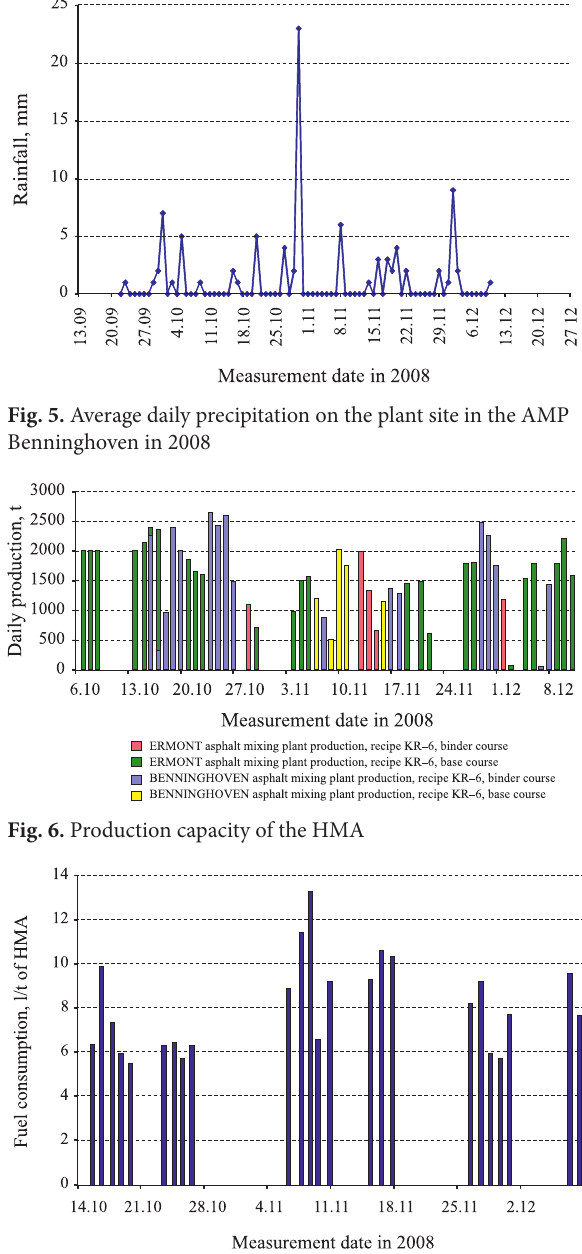
Fig. 7. Heating oil consumption per 1 t of produced HMA in AMP Benninghoven in 2008